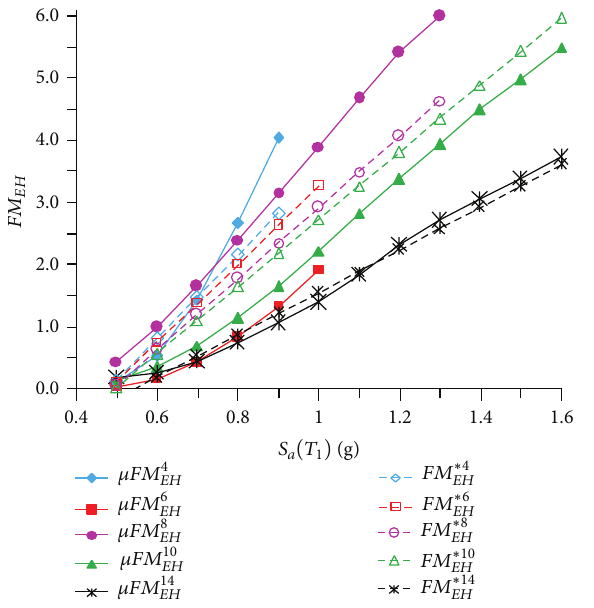
Figure 5: 𝐹𝑀 𝐸𝐻 in the ESDOFS.